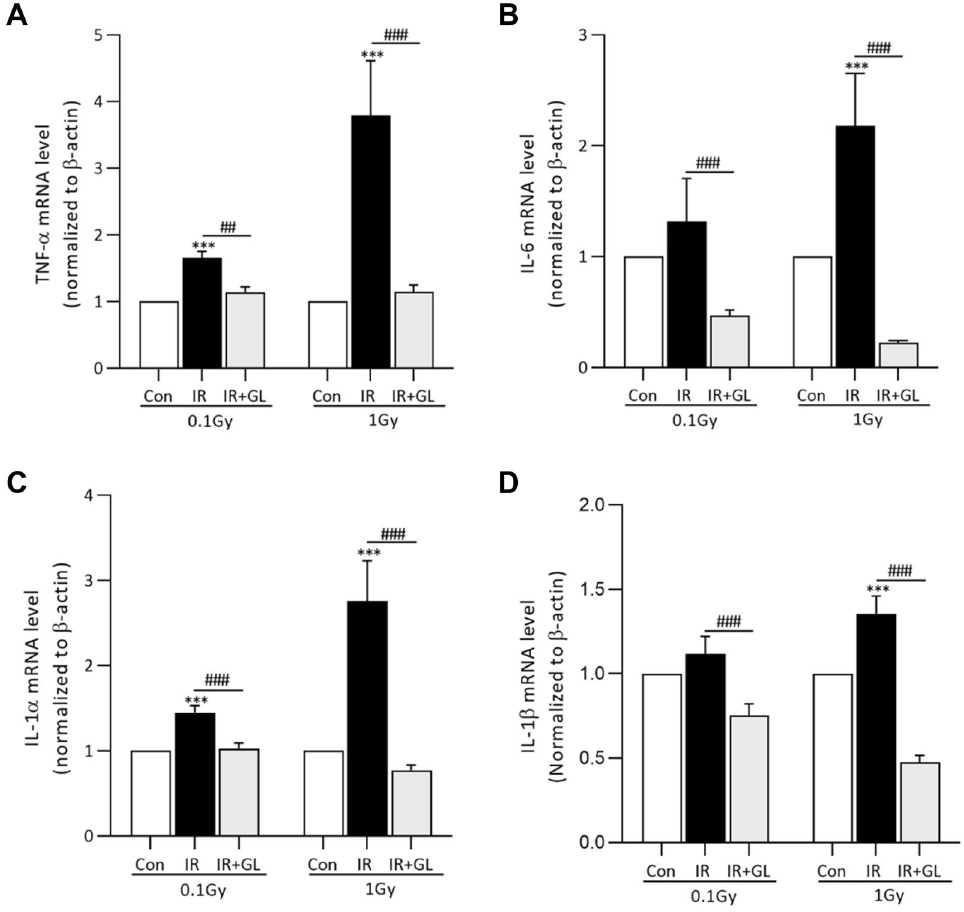
Figure 3. The mRNA expression of ( A ) TNF-α, ( B ) IL-6, ( C ) IL-1α, and ( D ) IL-1β according to radiation exposure. The mRNA expressions of pro-inflammatory cytokines were higher in the IR only groups compared to the controls with/without statistical significance, whereas it was significantly lower in the IR + GL groups than the IR only groups. Results are expressed as means ± SEM from duplicate experiments (n = 5) performed in each group. The asterisk (*) indicates significant differences between the control and IR groups (both IR only and IR + GL). The hash sign (#) indicates significant differences between the IR only groups and IR + GL groups. *** p < 0.001, ## p < 0.01, ### p < 0.001. IR irradiation, GL